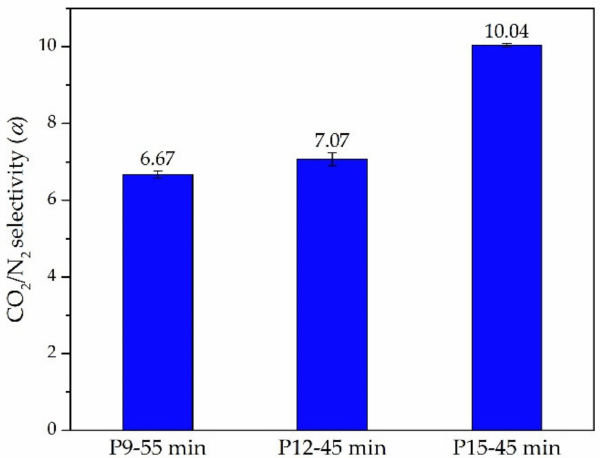
Figure 7. The CO 2 /N 2 selectivity for P9-55 min, P12-45 min and P15-55 min at 25 ◦